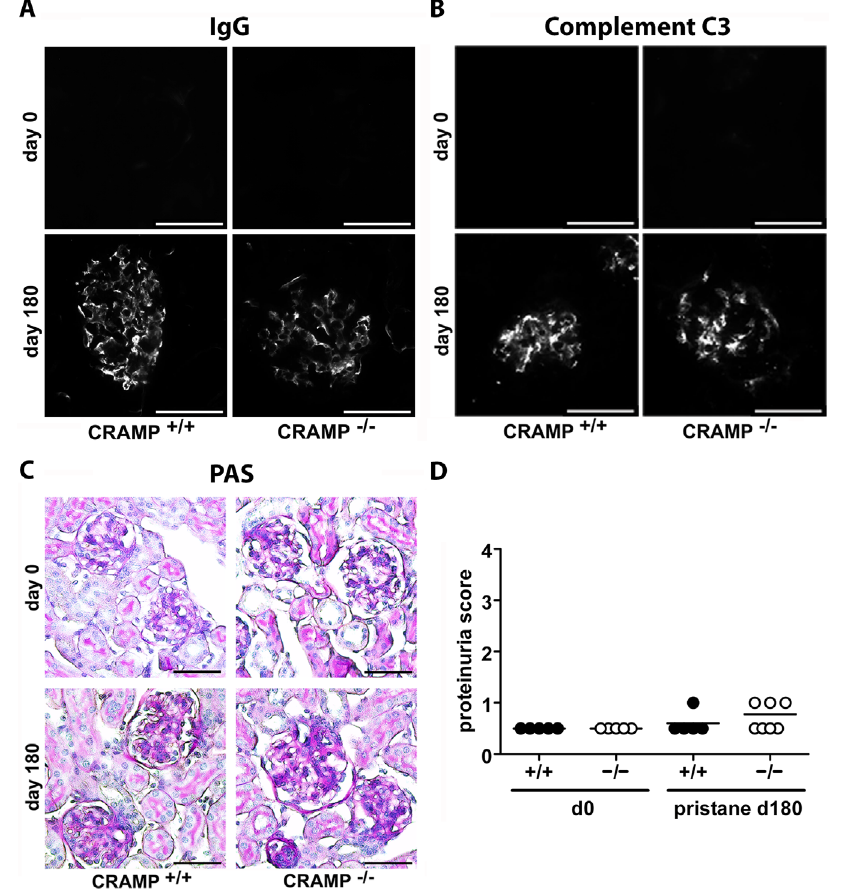
Fig. 6. Mild renal disease develops after pristane-injection in both WT andCRAMP 2 / 2 mice. Representative immunofluorescence images showing predominantly mesangial IgG-deposits (A) and complement C3 deposits (B) in WT and CRAMP-deficient mice before and 6 months after pristane-injection. Scale bars, 50 m m (C) Representative PAS-stainings of kidneys from unchallenged and pristane-injected WT and CRAMP 2 / 2 mice showing mild mesangial cell and matrix expansion at day 180 in both groups. Scale bars, 50 m m (D) Quantification of proteinuria in CRAMP + / + and CRAMP 2 / 2 mice before and 180 days after